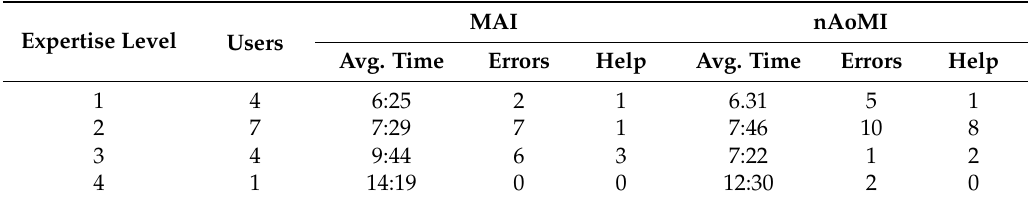
Table 1. Execution statistics categorized based on the users’ previous experience with intelligent systems.